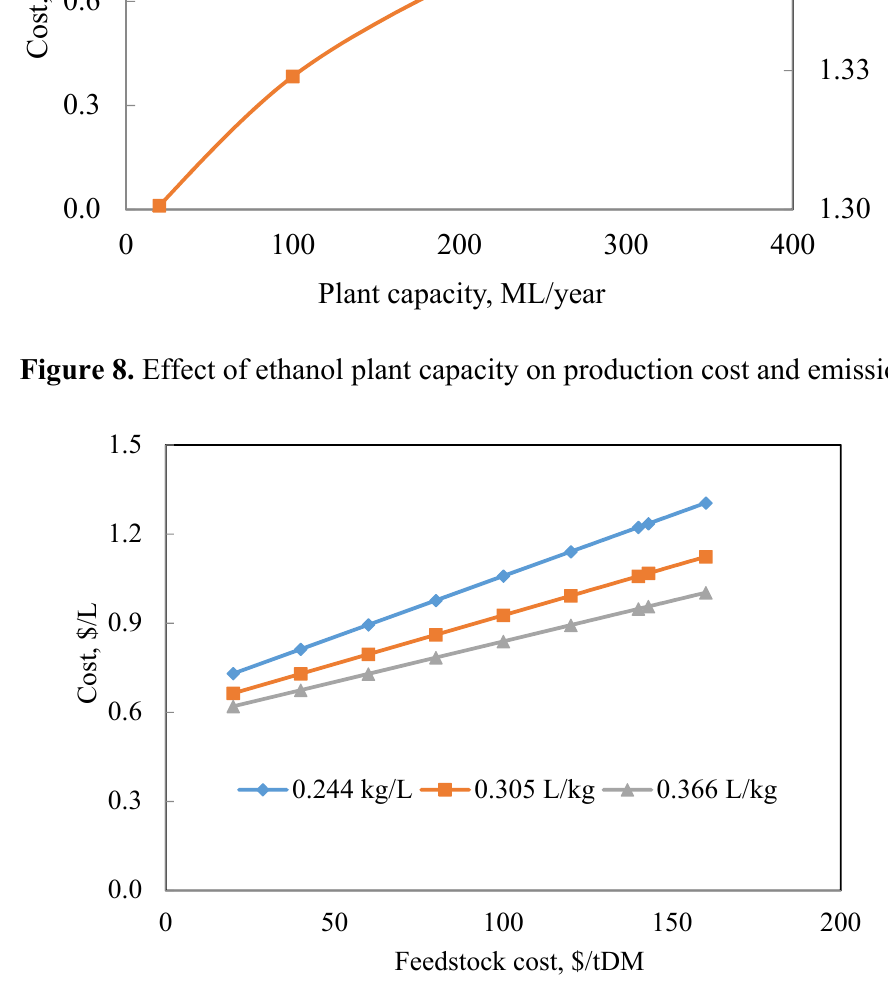
Figure 9. Effect of feedstock cost and ethanol yield on production cost and